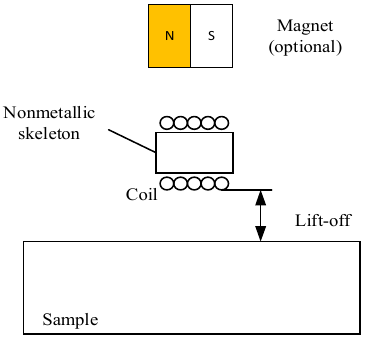
Figure 2. Configuration diagram of a magnetostriction-based EMAT.